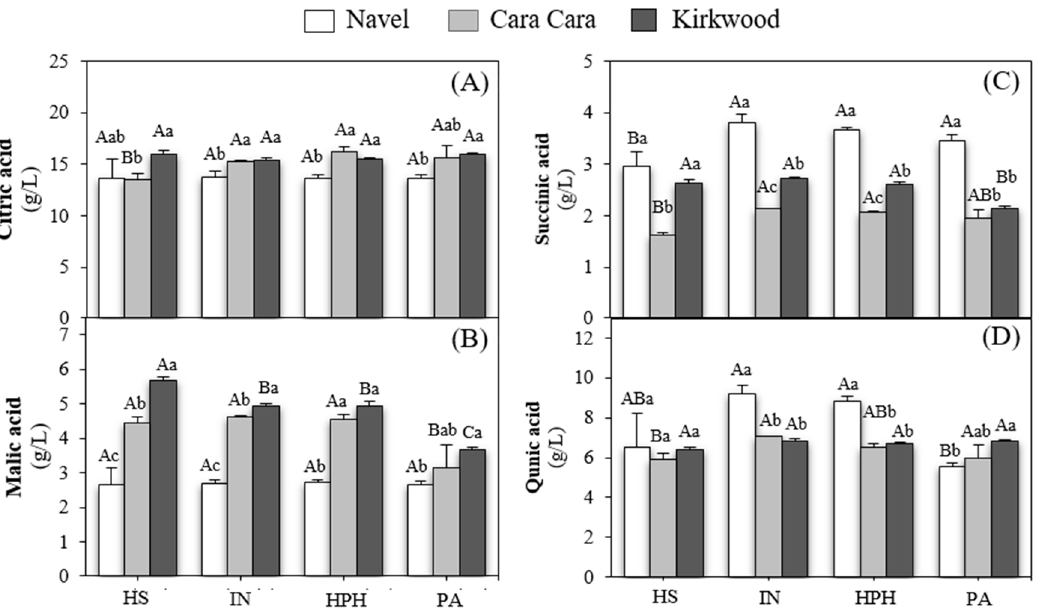
Figure 7. Content of citric acid ( A ), malic acid ( B ), succinic acid ( C ), and quinic acid ( D ) hand-squeezed (HS), industrial (IN), HPH, and pasteurized (PA) juices of NF, CC, and K orange. Uppercase letters indicate significant differences between different type of juices for the same variety, and lowercase letters indicate significant differences between varieties for the same type of juice one-way ANOVA ( p < 0.05).